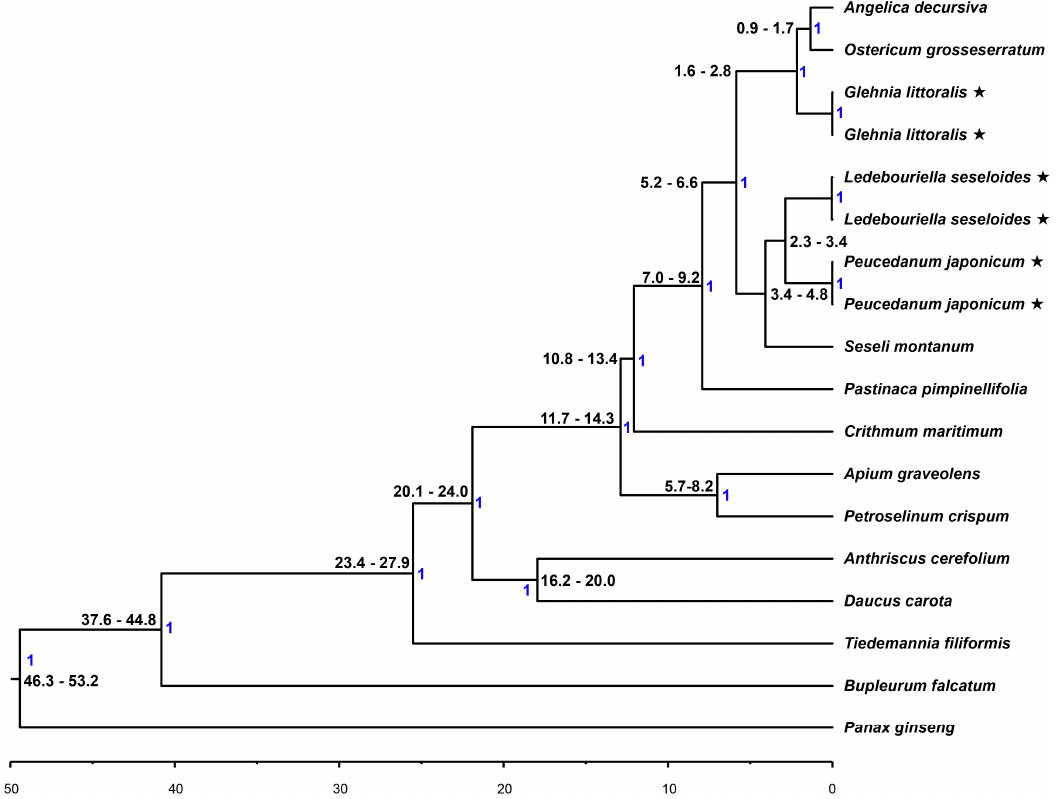
Figure 3. Phylogenetic relationship and estimated divergence time of 14 related Apiaceae species. A phylogenetic tree was constructed with BEAST, using 76 protein coding sequences common to cp genomes, including those of the Panax ginseng cp genome as an outgroup. Divergence times were estimated based on the divergence time (49 Mya) between Daucus carata (Apiaceae) and P. ginseng (Araliaceae). Posterior probability value indicated by blue color.